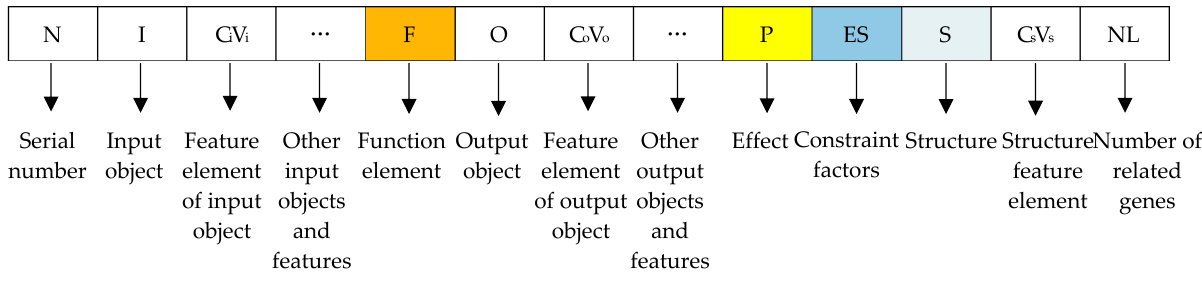
Figure 7. The scenario-related products acquisition model based on the object.